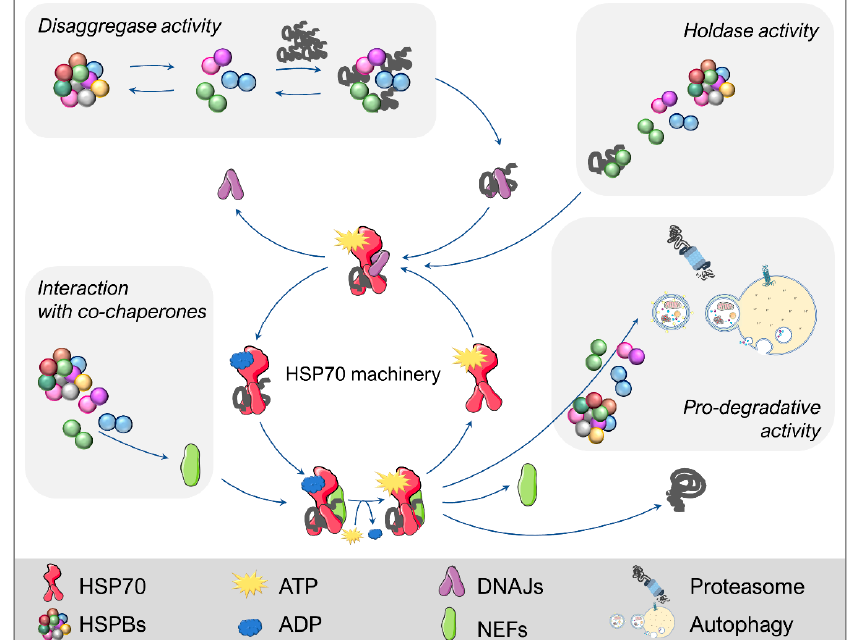
Figure 2. HSPBs participation in the PQC system. The HSP70 machinery is the core system of the proteostasis network. HSP70s perform folding cycles using ATP and collaborating with other chaperones (e.g., DNAJs) and co-chaperones, such as NEFs. HSPBs directly or indirectly interplay with HSP70 by exerting a disaggregase activity and by keeping client proteins in a refolding- competent state (holdase activity). Additionally, some HSPBs cooperate with co-chaperones and/or facilitate the routing of client proteins to degradation, which can occur through autophagy and the proteasome. This figure was created using Servier Medical Art templates, which are licensed under